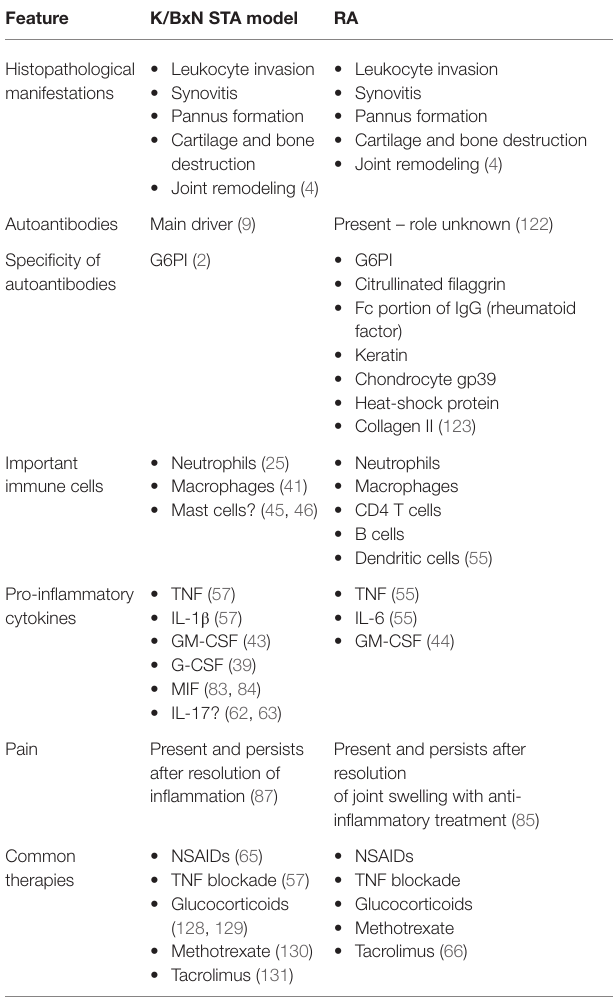
TABLe 2 | Similarities and differences between the K/BxN STA and RA